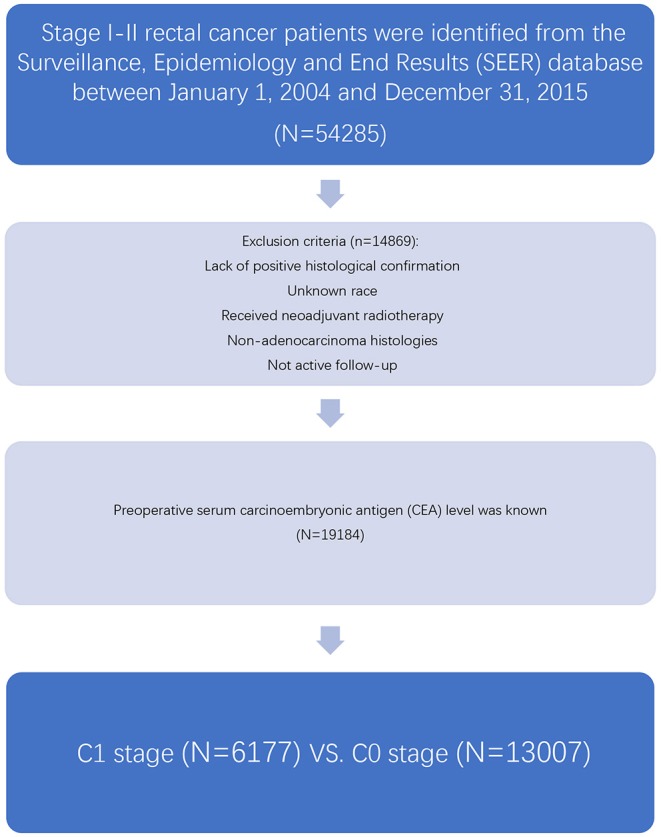
Flow chart of patient cohort definitions.